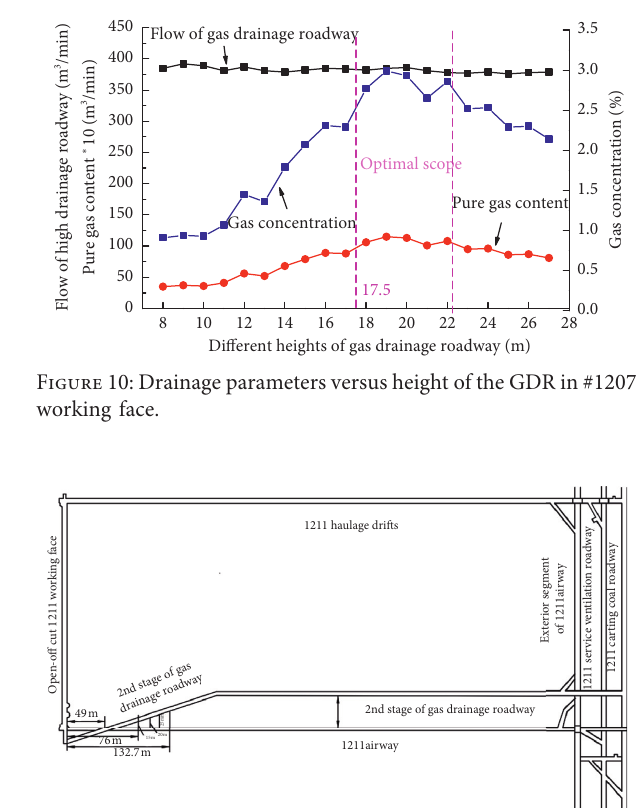
Figure 11: Layout of the GDR in 1211working face.